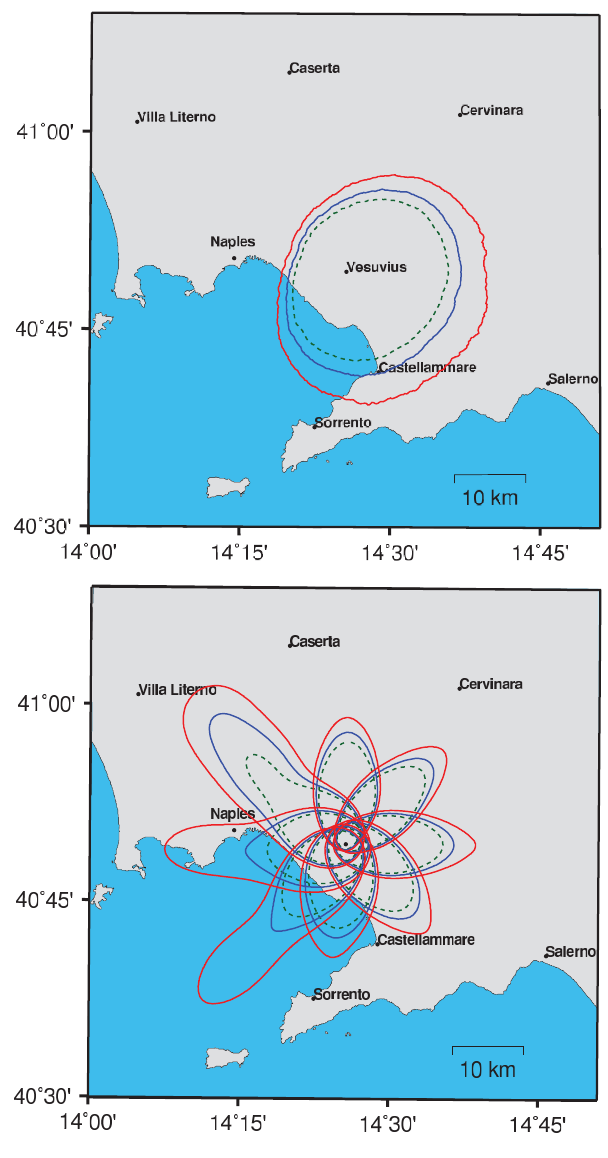
Fig. 3. Top: 5% tephra loading probability curve to exceed 500kgm − 2 for Sub-Plinian I scenario under dry (green dashed line) and wet (full lines) conditions for 100mm (blue line) and 200mm (red line) of rainfall. Bottom: Simulations of tephra loading using 8 different wind profiles representative of 8 ra- dial sectors for a loading 500kgm − 2 for Sub-Plinian I scenario under dry (green dashed line) and wet (full line) conditions for 100mm (blue line) and 200mm (red line) of